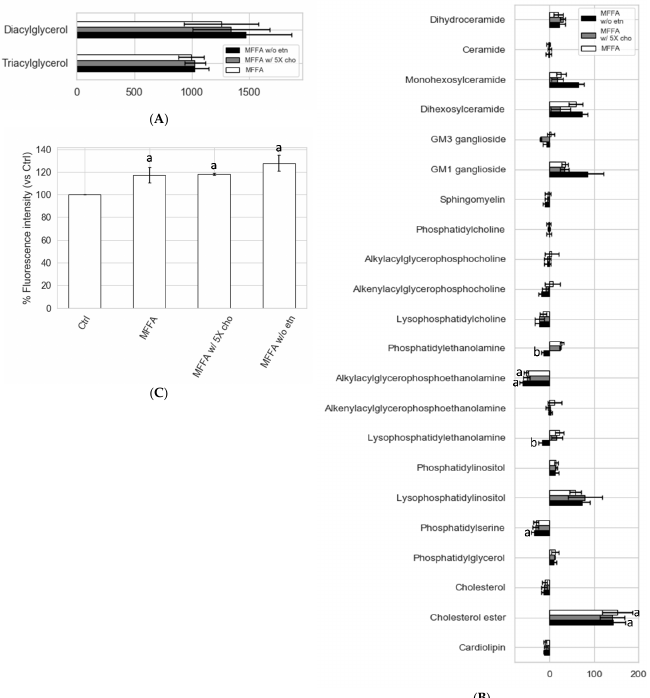
Figure 7. Impacts of altered supplies of key nutrients involved in phospholipid biosynthesis on steatotic hepatocyte lipid profile and cell death. Isolated rat hepatocytes were treated without (Ctrl) or with 2 mM of MFFA in special DMEM media of which choline has been increased to five times of the standard doses (i.e., 150 μM, MFFA w/5X cho), or had ethanolamine removed completely (MFFA w/o etn) for 24 h, before being harvested and LC-MS lipidomic analysis performed. Mean percentage differences (vs Ctrl) of the lipid classes under different treatment conditions are shown ( A , B ; data shown as mean % difference ± sem); a: p < 0.05 vs. Ctrl group, as determined by a Kruskal–Wallis test followed by Mann–Whitney U tests; p -values were Benjamini–Hochberg corrected; n = 5 for Ctrl, MFFA and MFFA w/o etn groups; n = 4 for MFFA w/5X cho group). For cell death determination, rat hepatocytes were treated with the abovementioned media for 48 h before being trypsinized and stained with propidium iodide dye and analyzed with a flow cytometer. Relative fluores- cence intensities vs. Ctrl (as 100%) are shown as ( C ) (data shown as mean ± sem; a: p < 0.05 vs. Ctrl group; b: 0.05 < p < 0.075 vs. MFFA group, Mann–Whitney U test; n = 4 for Ctrl, MFFA and MFFA w/o etn groups; n = 2 for MFFA w/5X cho group).